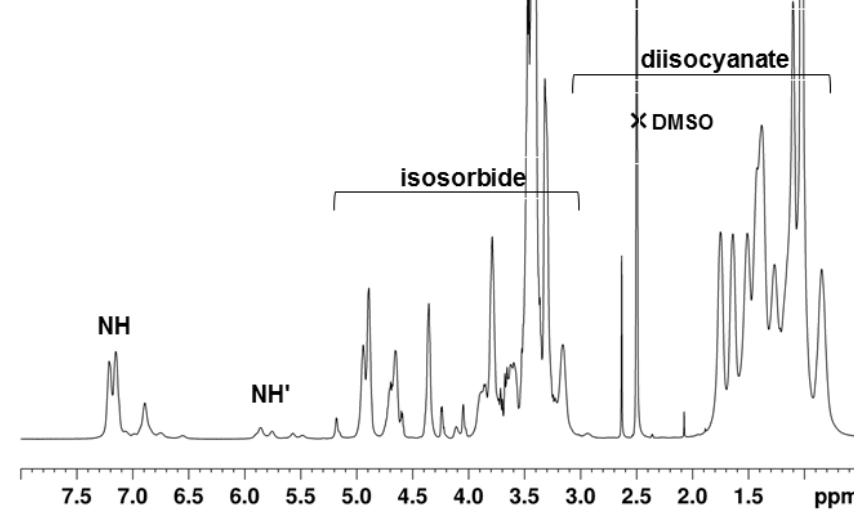
Figure 7. The 1 H NMR spectrum of PU4 in DMSO- d 6 . Protons of the terminal groups are primed.